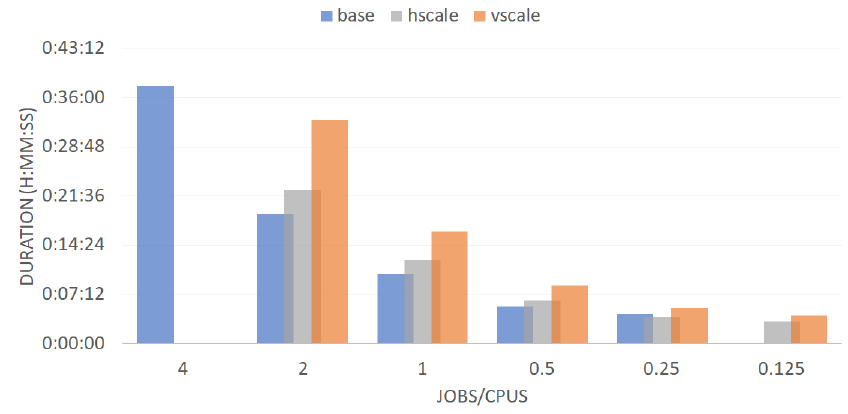
Figure 5. Average duration of jobs versus the concurrency per total cores in each one of the three studied